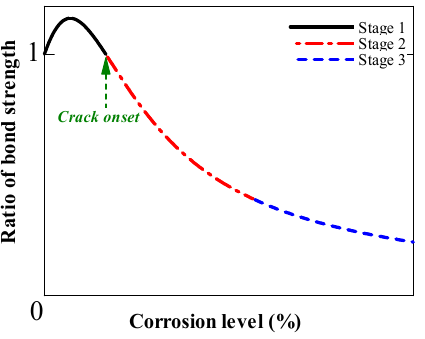
Figure 12. Degradation of bond strength with corrosion level.